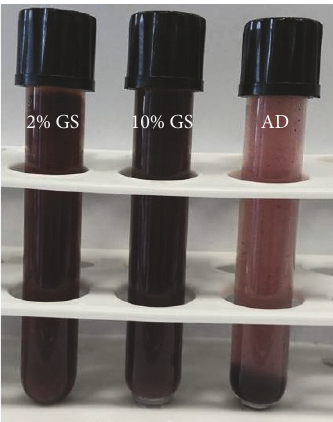
Figure 2: Sedimentation behavior of semiliquid GS, 2% d.w. (2% GS); semiliquid GS, 10% d.w. (10% GS); and air-dried GS (AD). The 2% GS sample was not diluted, while the 10% GS and AD samples weredilutedwith8.0 mMpotassiumcitratebuffer,pH3.0,toachieve 2% of dried solids as for 2%